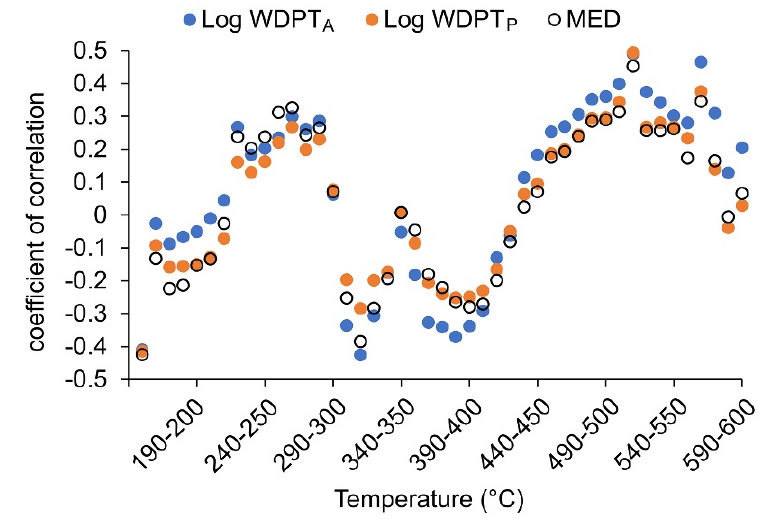
Figure 6. Correlation (Pearson’s) between SWR data and mass portions of SOM degraded/volatilized per 10 °C interval (0.29; 0.38; 0.47 values correspond to p < 0.05; 0.01; and 0.001 significance level).